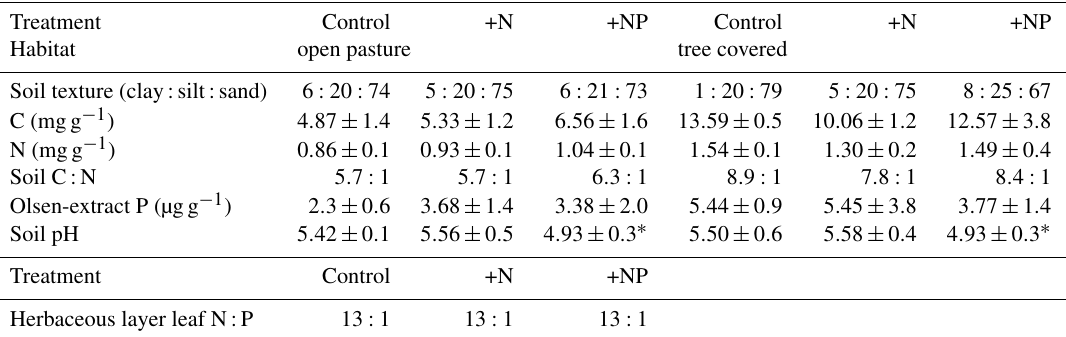
Table 1. Summary of pretreatment measures within EC footprints (“treatments”). All measurements were made in November 2013 for soil and in spring 2014 for plants. All soil properties are measured on surface (0–5cm) soil and open-pasture leaf N:P are a biomass-weighted aggregate of samples of grass and forbs (98% of herbaceous layer biomass). All errors are standard deviations. Soil nutrient contents (C, N and Olsen P) were always significantly higher in tree-covered than open-pasture microhabitats ( P < 0 . 005, P < 0 . 005, P < 0 . 05 respectively). There were no significant effects due to footprint except soil pH ( ∗ p < 0 . 05) but this did not result in a difference of weighted mean vegetative N:P ratios, so we considered this unimportant for the overall